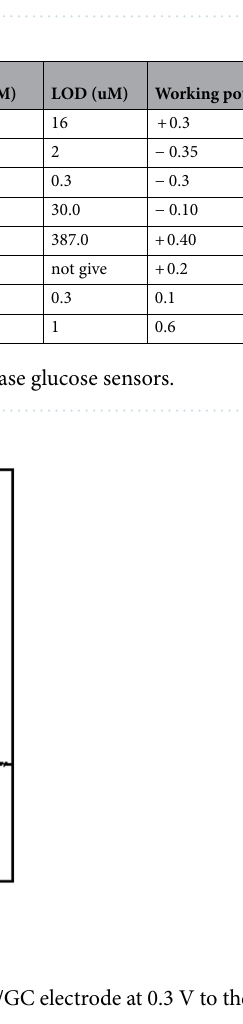
Figure 5. ( a ) Amperometric response of the PtNi alloy-graphene/GC electrode to successive addition of 0.5 and 1 mM glucose in 0.1 MPBS at an applied potential of 0.3 V and ( b ) corresponding calibration curve.